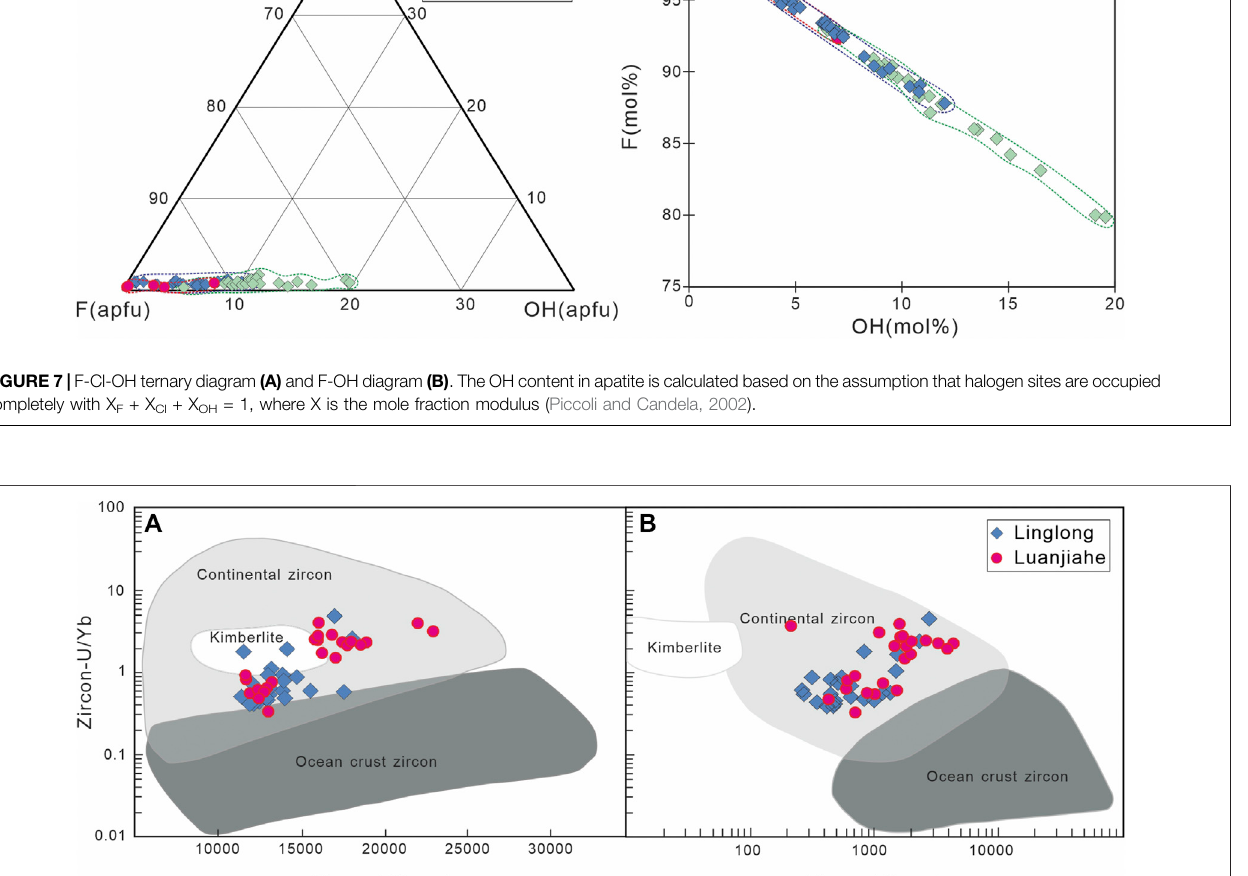
Frontiers in Earth Science |